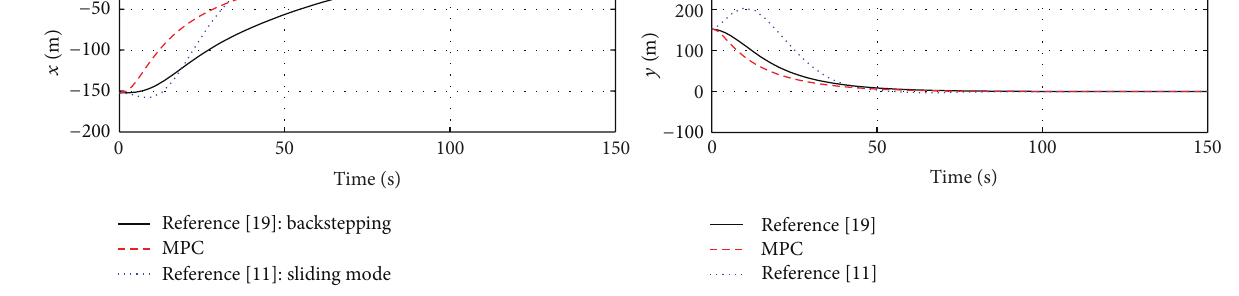
Figure 2: Trajectory of 𝑥 and 𝑦 .